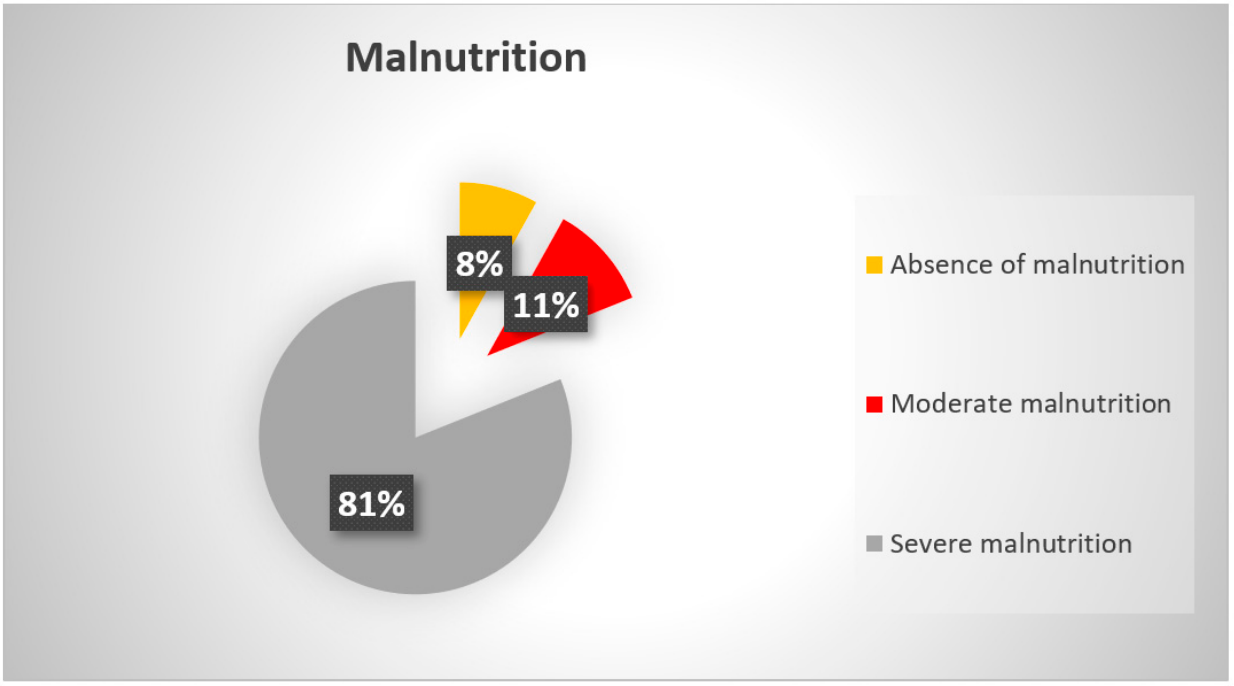
Figure 4. Degree of malnutrition due to COVID-19 at admission to the rehabilitation center.